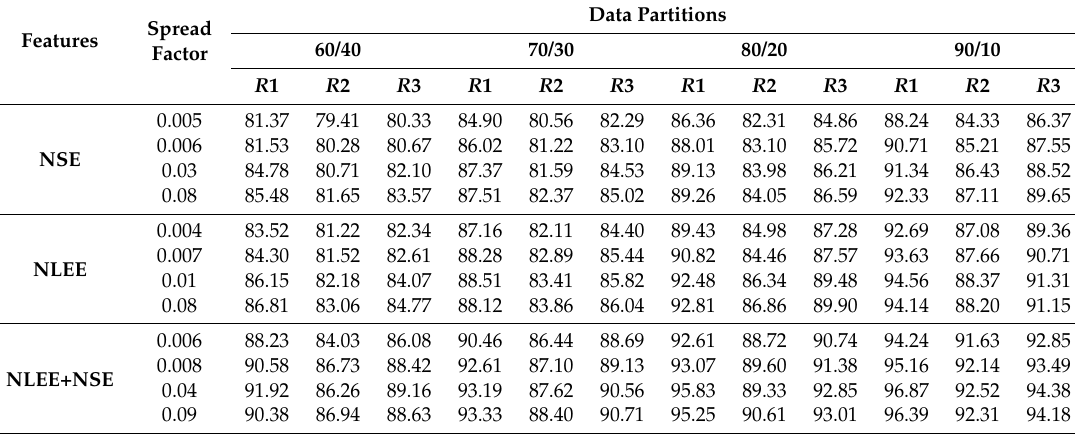
Table 5. PNN classification results at level 6 of wavelet packet decomposition using